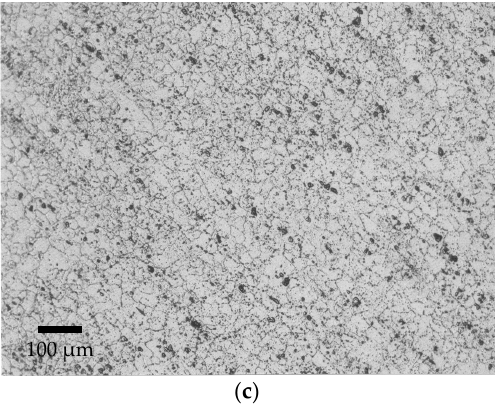
Figure 2. Grain structure of surface layers of ( a ) as-received; ( b ) with 7% cold rolling; and ( c ) with 15% cold rolling 5083 aluminum alloy after chemical etching with Graff’s reagent.